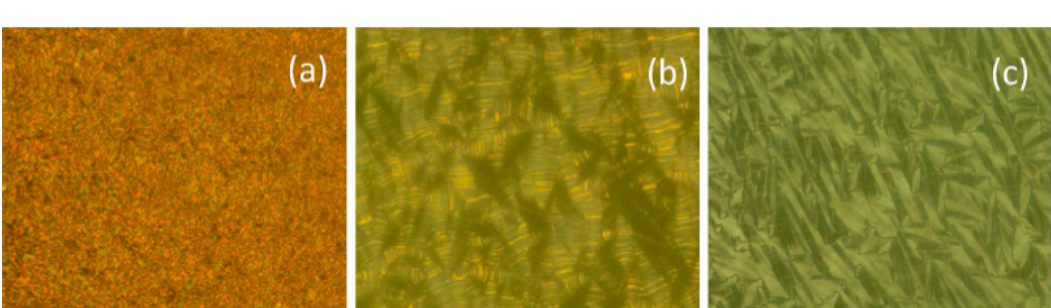
Figure 12. Changes in the texture of the smectic phase in compound 47 observed under a triangular wave at T = 110 °C with increasing voltage from ( a ) 0 V pp µm − 1 , ( b ) 30 V pp µm − 1 to ( c ) 35 V pp µm − 1 . (Reproduced with permission from ref. [121], copyright American Chemical Society 2018, https: // doi.org / 10.1021 /